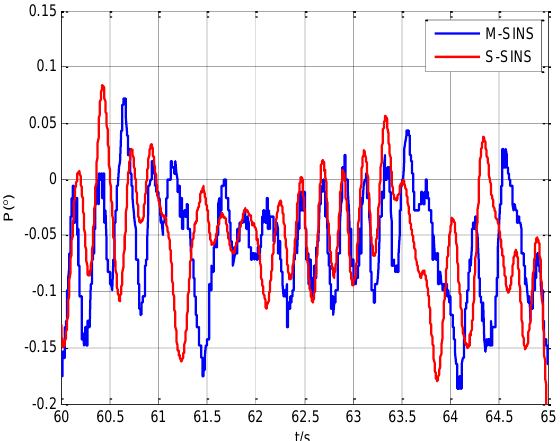
Figure 6. The pitching angles’ curves of M-SINS and S-SINS.